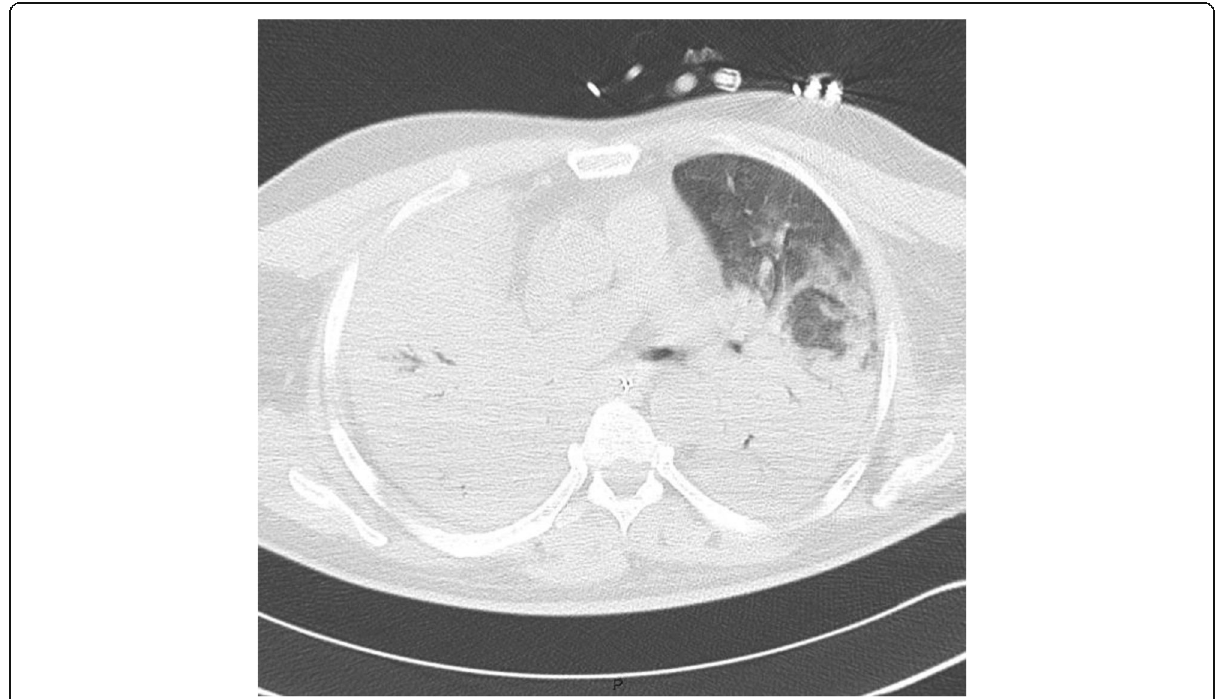
Fig. 2 Chest computed tomography angiography without vascular abnormalities. A complete condensation of the right lung and three-quarter condensation of the left lung may be observed